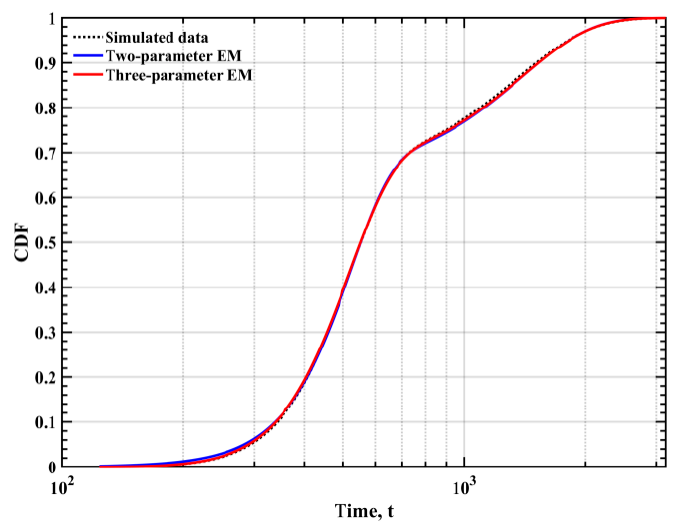
Figure 3. Simulation of the cumulative distribution function of the mixed Weibull distribution. The parameter estimates we obtained with different methods are shown in Table 1. Table 1. Simulation parameter estimation results.